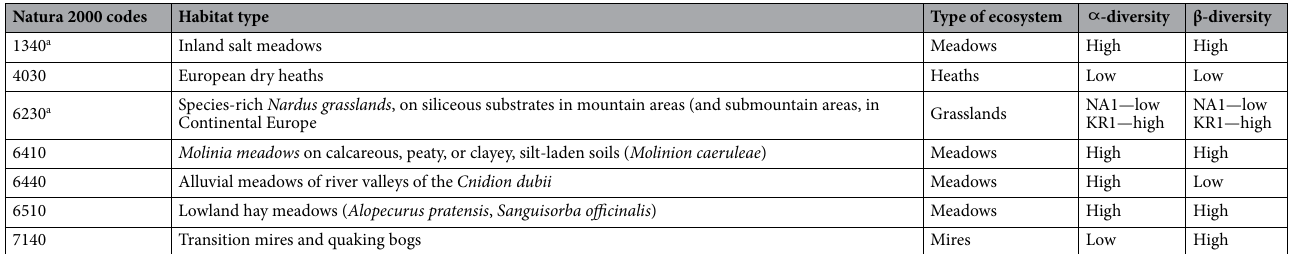
Table 1. Analysed Natura 2000 habitats. a Priority Natura 2000 habitat.